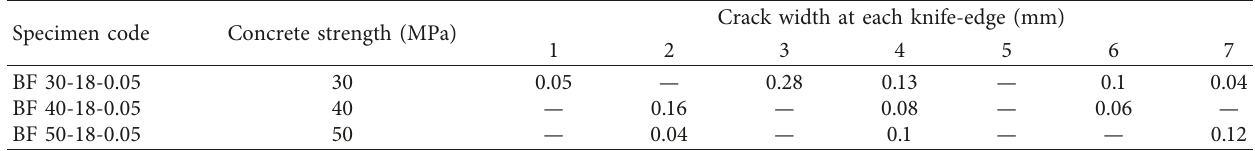
Table 11: Crack width of test specimens with different concrete strength values.